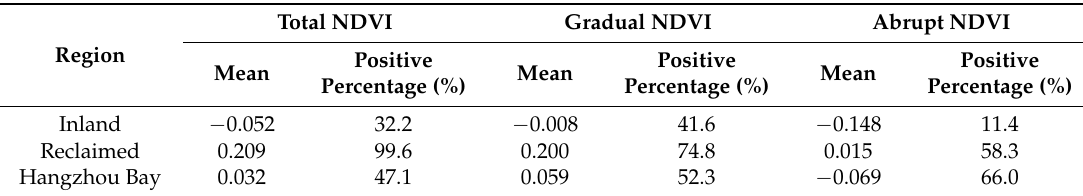
Table 6. The mean and positive percentage of total, gradual and abrupt NDVI at Hangzhou Bay in Zhejiang Province, China.